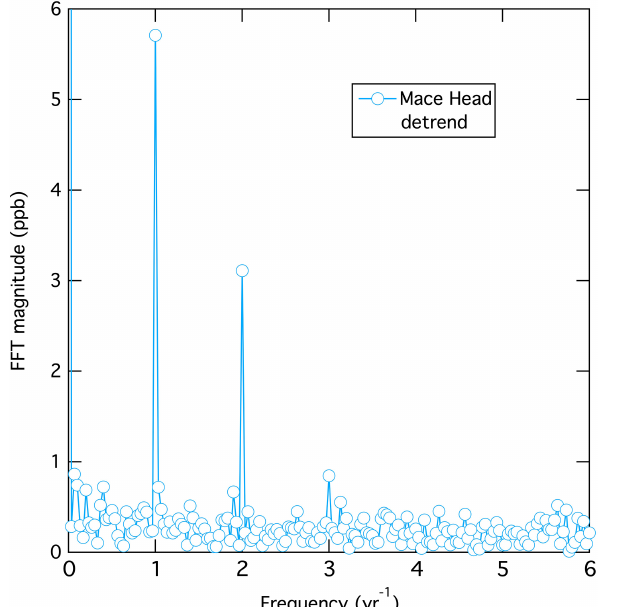
Figure 2. Results of the Fourier transform of the detrended monthly mean ozone concentrations.